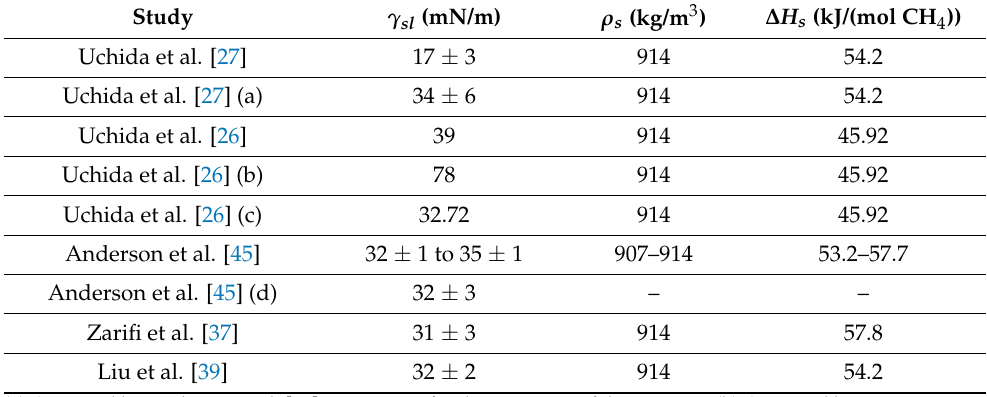
Table 1. Comparison of calculated values for γ sl (methane hydrate–liquid water), using experimental measurements reported by different studies (adopted from Tsimpanogiannis